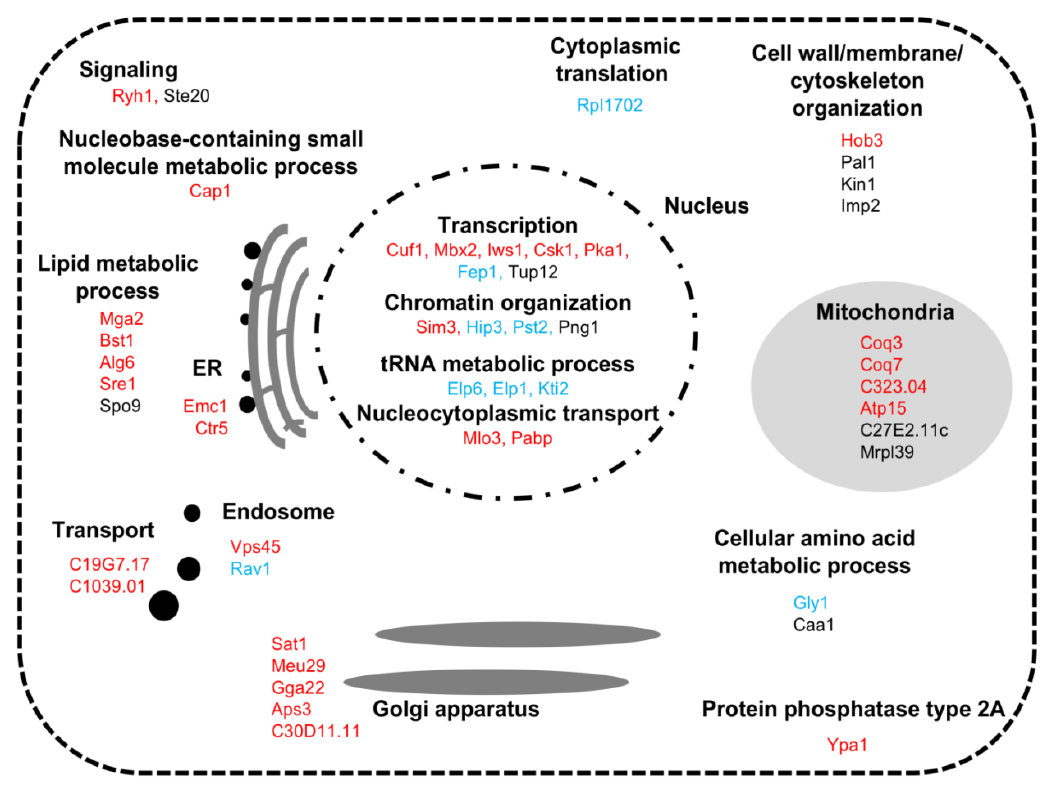
FIGURE 3: Summary of identified the FTY720-sensitive genes Functional classification and sub-cellular localization of FTY720 sensitive gene